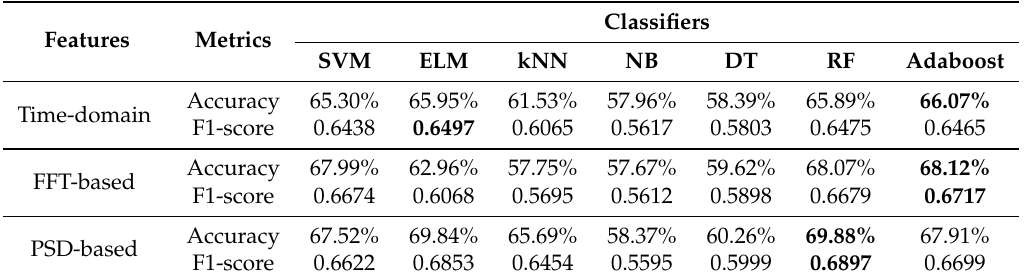
Table 1. Performance of Seven Different Classifiers Using Time-Domain and Freq-Domain Feature Extraction